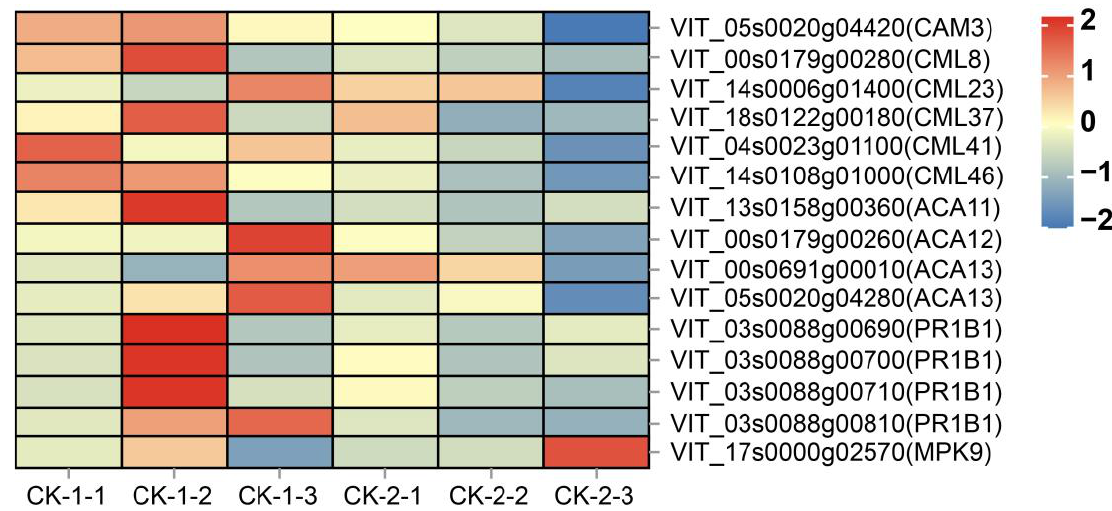
Figure 5. Heatmap of gene expression related to signal transduction.